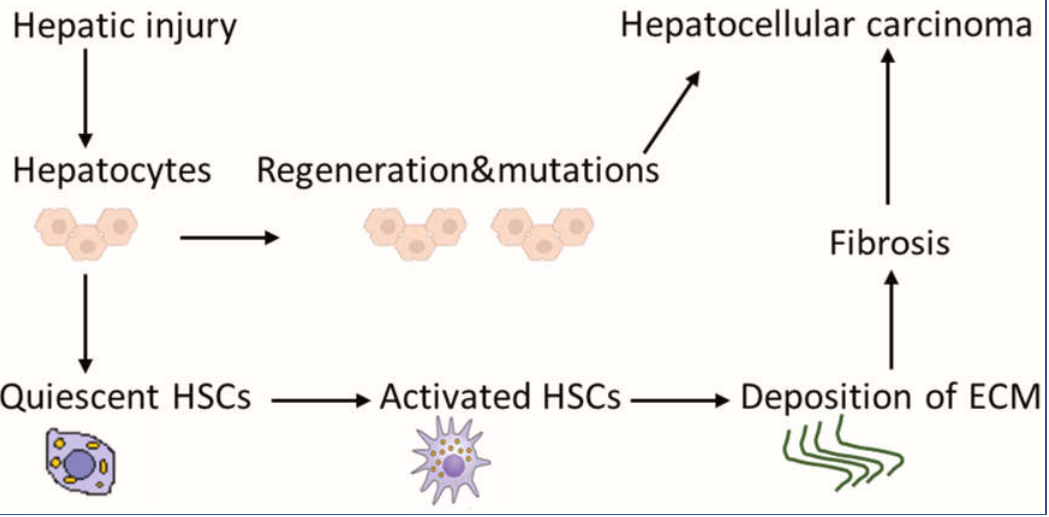
Figure 1. Scheme for the contribution of HSCs to liver pathology. HSCs exist in a quiescent state, containing numerous vitamin A lipid droplets. When the liver is injured, damaged hepatocytes mediate HSC activation, which could produce a large amount of ECM, leading to fibrosis as an indirect mechanism of HCC. Mutations during the regeneration of hepatocytes may lead directly to the development of HCC. Abbreviations: HSCs: hepatic stellate cells, HCC: hepatocellular carcinoma and ECM: extracellular matrix.